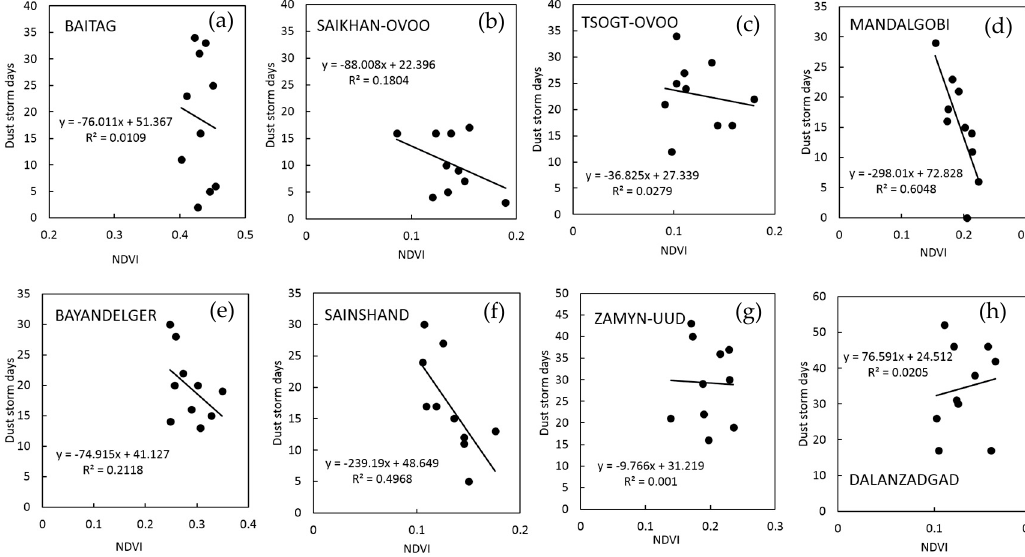
Figure 8. ( a – h ) Relationship between dust storm days and NDVI at each station.